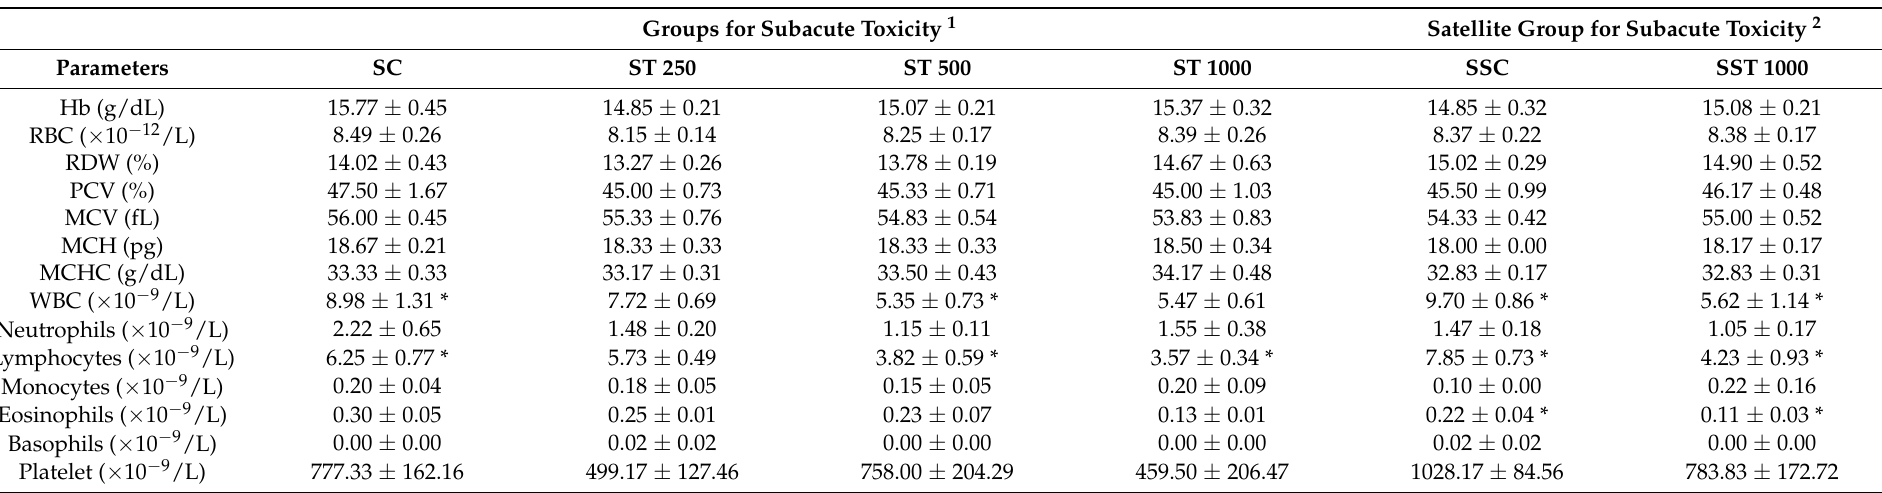
Table 10. The haematological effects of the different treatment dose of E. tapos yoghurt on female SD rats in the subacute toxicity study. Values are expressed as mean ± SEM. (*) indicates a significant difference at p <